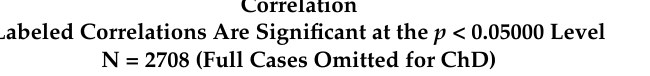
Figure 9. Example of comparison of output signals from the experimental e-nose and TDS for testing the budding of the addition of 0.5 g dried yeast (Thymos, s pol. s r.o., Veľká Lomnica, Slovakia) in sugar solution (70 g/L). The moment when yeast was added into the sugar solution is marked by the dashed line. Table 6. Correlation coefficients for the comparison of output signals from the experimental e-nose and TDS testing for the budding of the addition of 0.5 g of dried yeast (Thymos, spol. s r.o., Veľká Lomnica, Slovakia) in sugar solution (70 g/L) from Figure 9. Calculated in STATISTICA CZ version 12 (StatSoft, Inc., USA).